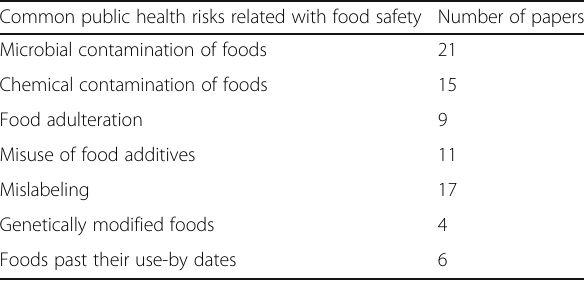
Table 1 Common food safety – related public health risks identified from the search process Common public health risks related with food safety Number of papers Microbial contamination of